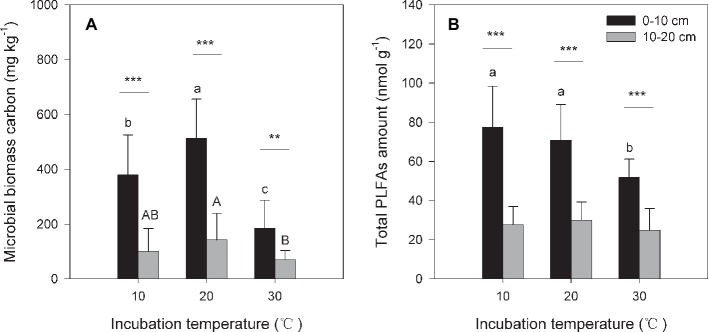
Soil microbial biomass carbon [MBC (A)] and total amount of phospholipid fatty acids [PLFAs (B)] under different incubation temperatures. The bars are the average values, and the error bars are the standard deviations (n = 4). Different lowercase letters above the bars indicate significant differences among the temperature treatments for surface soil, while uppercase letters indicate significance for subsurface soil. Double and triple stars indicate significant differences between the soils under each of the incubation temperatures at significance levels of p < 0.01 or p < 0.001, respectively.